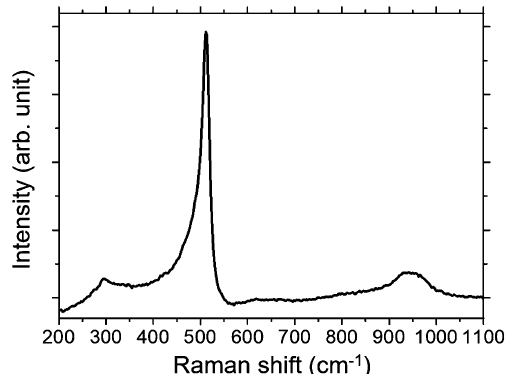
Figure 4. Raman spectra of the sample after 50 W of laser beam irradiation for 80